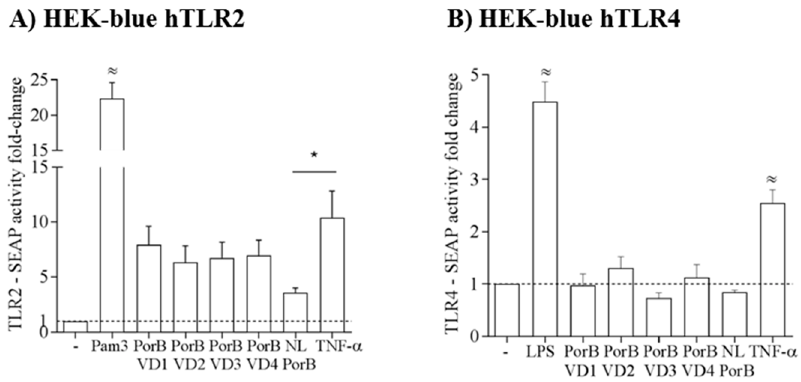
Figure 5. PorB/VDs induce TLR2 activation and are free of LPS. ( A ) HEK-blue-hTLR2 cells were incubated with medium alone, purified PorB/VDs and NL PorB (10 µg/mL), Pam 3 CSK 4 (100 ng/mL) and TNF- α (50 ng/mL). ≈ p < 0.0001 by one-way ANOVA with Tukey’s multiple comparisons test; ( B ) HEK-blue hTLR4 cell were incubated with NL PorB and PorB/VDs as in ( A ), and with E. coli LPS (100 ng/mL). SEAP activity was measured spectrophotometrically at OD 620 directly in the plate after 14–16 h and is reported as fold-change relative to medium alone ± SEM. ≈ p < 0.0001 as above; * p < 0.05 by unpaired t test.